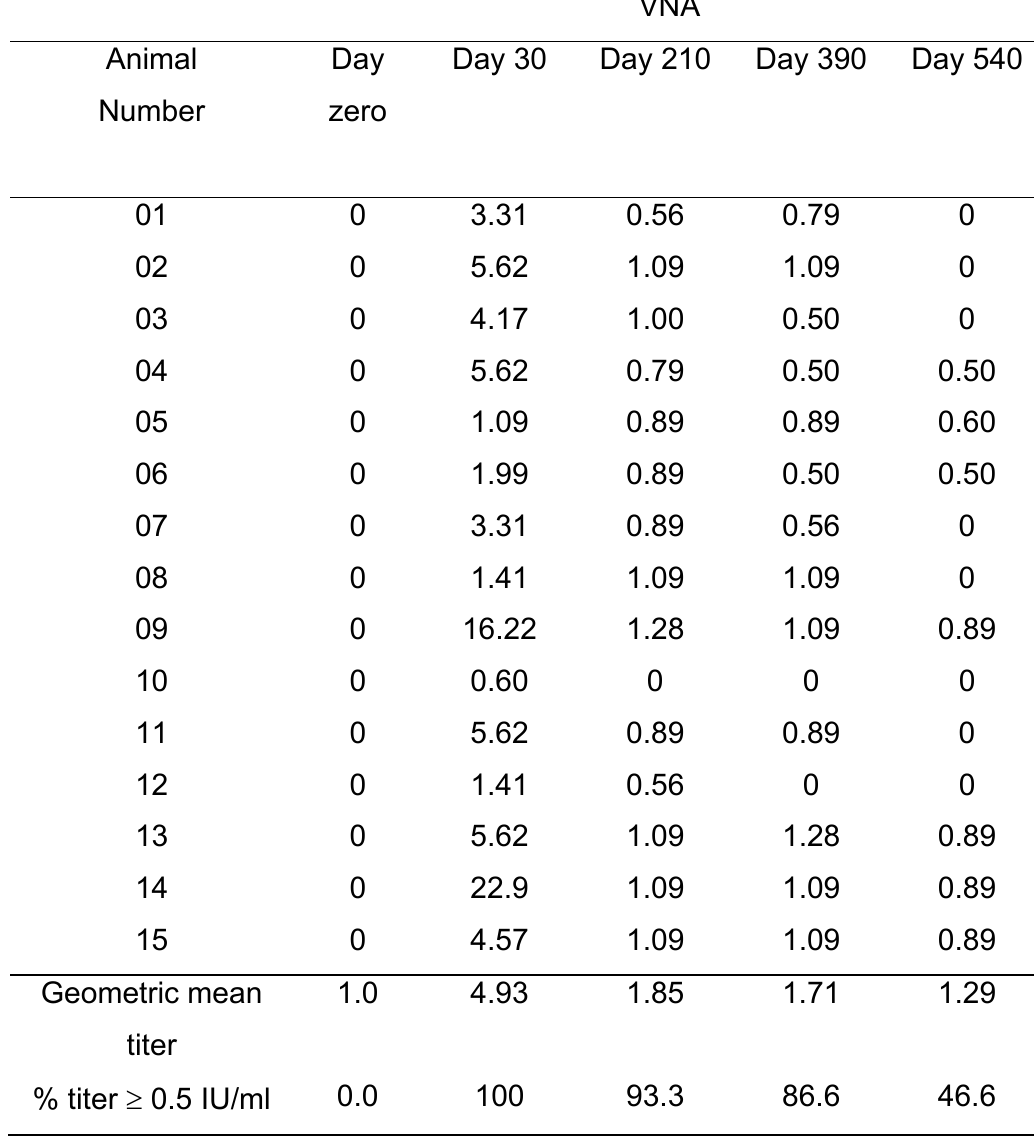
Table 1: Virus neutralizing antibody (VNA) titers in cattle immunized with a single dose of rabies inactivated vaccine (Group